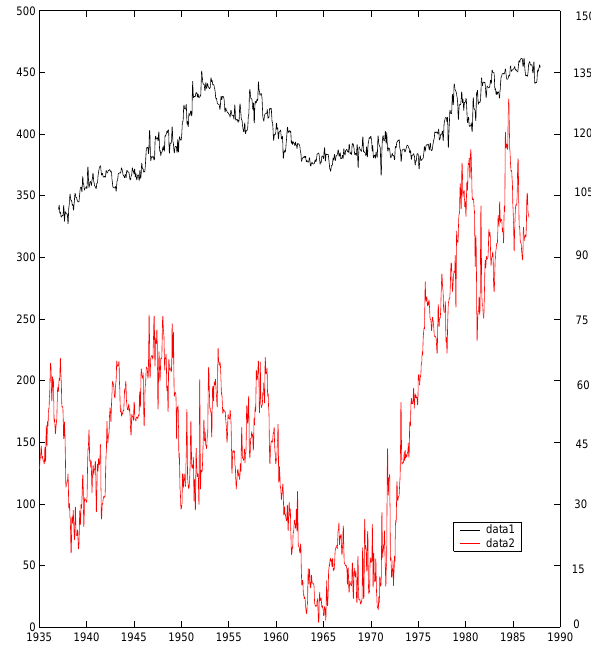
Fig. 10. Amplitude of the 6-month line (1) X component, HAD observatory (2) aa index. Vertical unit: .35 10 − 3 nT/day. Right vertical scale is for aa .